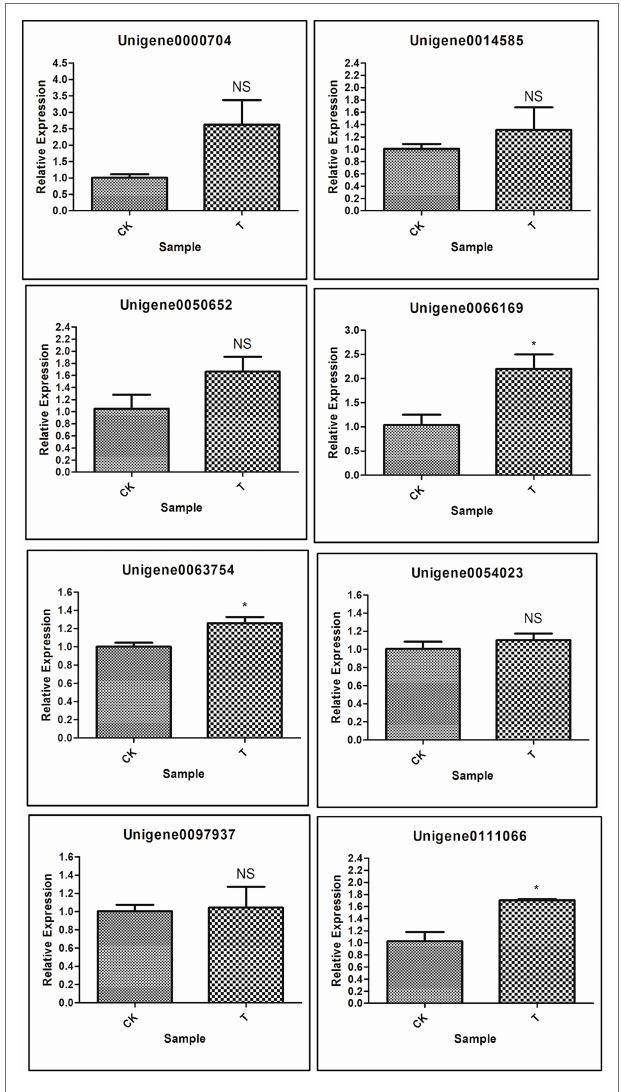
FIGURE 13 | Validation of selected genes involved in rooting by qRT-PCR; Significant ( p < 0.05) differences between CK and treatment are indicated by an